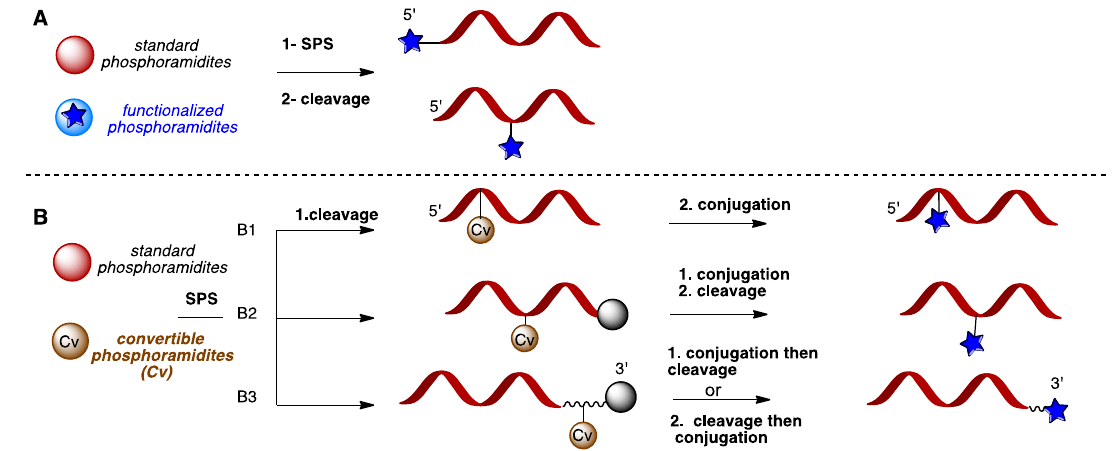
Scheme 1. Schematic representation of the two strategies (illustrated with the supported phosphoramidite synthesis) used for the synthesis of functionalized ONs either by: ( A ) incorporation of an already functionalized building block; ( B ) incorporation of the convertible handle by SPS, followed by conjugation in solution (B1), or on-support conjugation, followed by deprotection and cleavage (B2), and incorporation at the 3’-position of the oligonucleotide (B3) with conjugation either before or after cleavage from the support.